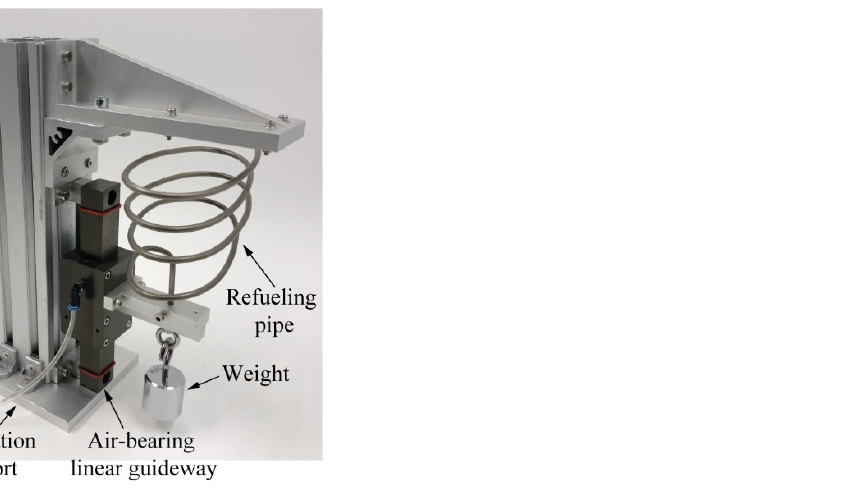
Figure 18. Experiment for axial stiffness testing of the elliptical-helical pipe with bias loading.